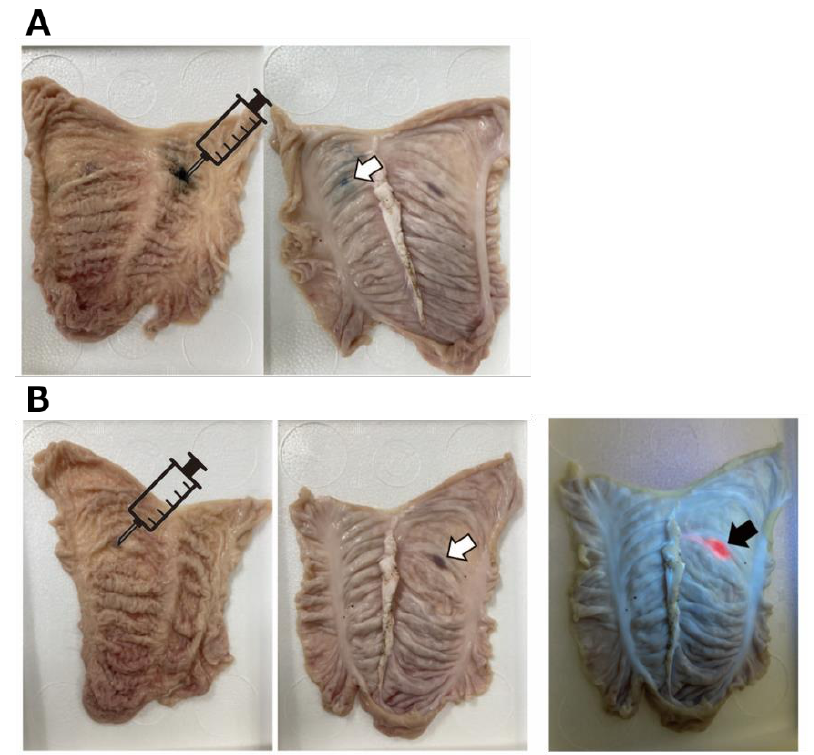
Figure 7. The photographs showing the marking of (A) India ink and (B) PMETAC- co -PAMPAA(HpD) in the porcine colon tissue. ( A ) ( left ) India ink was injected from mucosal sides. The illustrations of syringes indicate the location of injection site. ( right ) The photographs from the serosal side (outside of the digestive tract) after local injection. White arrows indicate the location of injection site. ( B ) ( left ) PMETAC- co -PAMPAA(HpD) was injected from mucosal sides. The illustrations of syringes indicate the location of injection site. ( middle ) The photographs from the serosal side (outside of the digestive tract) after local injection. White arrows indicate the location of injection site. ( right ) The photographs from the serosal side under the irradiation at 375 nm. Black arrow indicates the strong fluorescent signal of injection